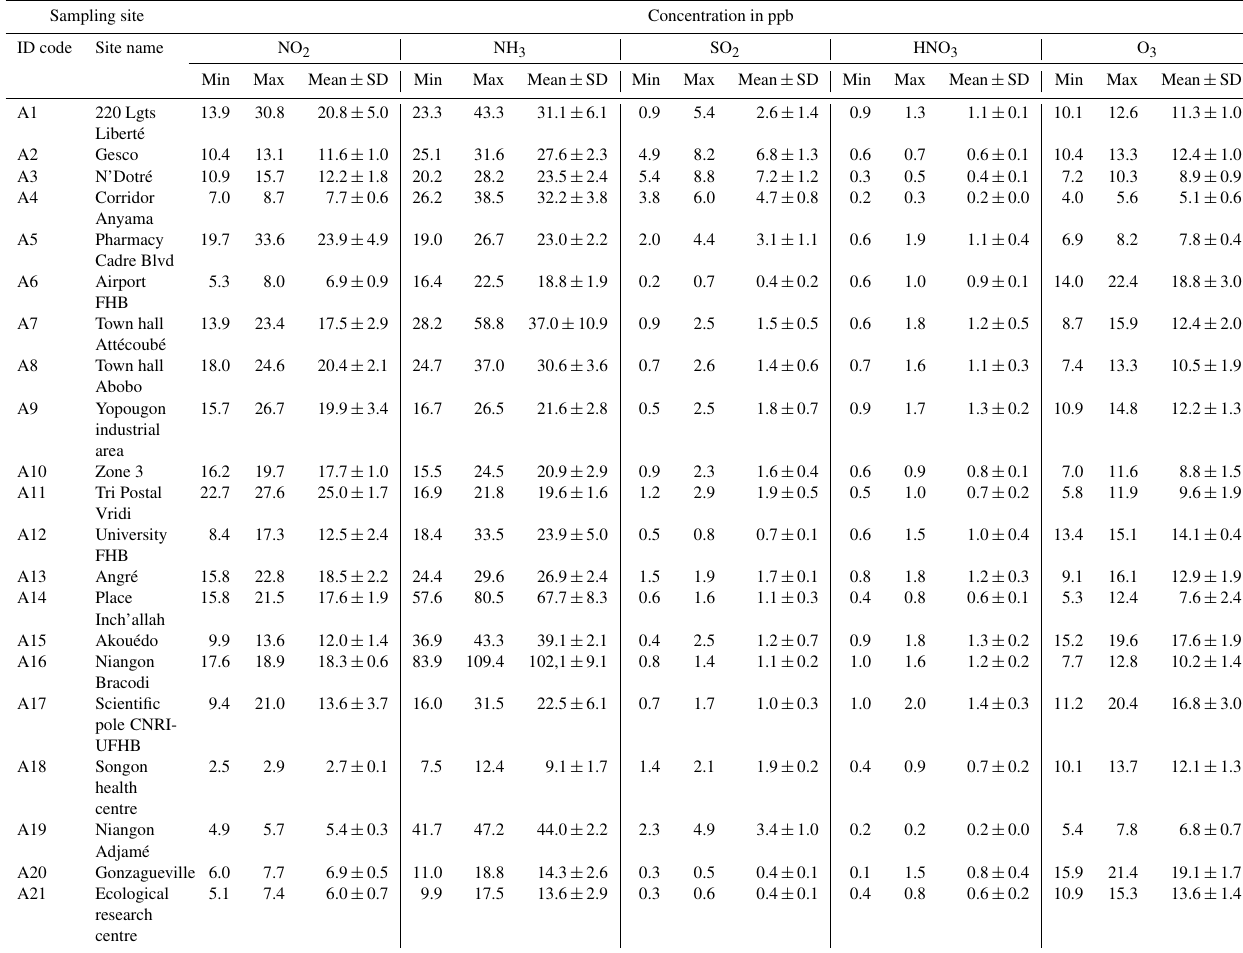
Table 4. Gaseous pollutants’ concentrations and standard deviation (SD) at 21 sampling sites in Abidjan during the dry season (15 Decem- ber 2015–16 February 2016). Sampling